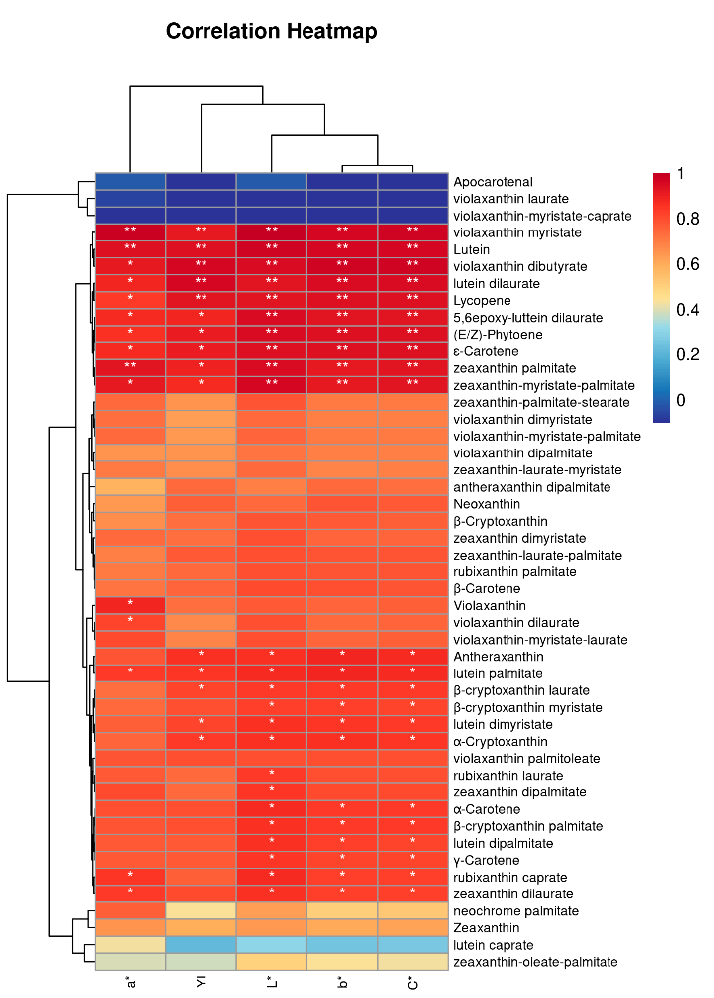
Figure 3. Correlation of color attributes and carotenoids content. “*” means significant correlation ( p < 0.05); “**” indicates extremely significant correlation ( p < 0.01).